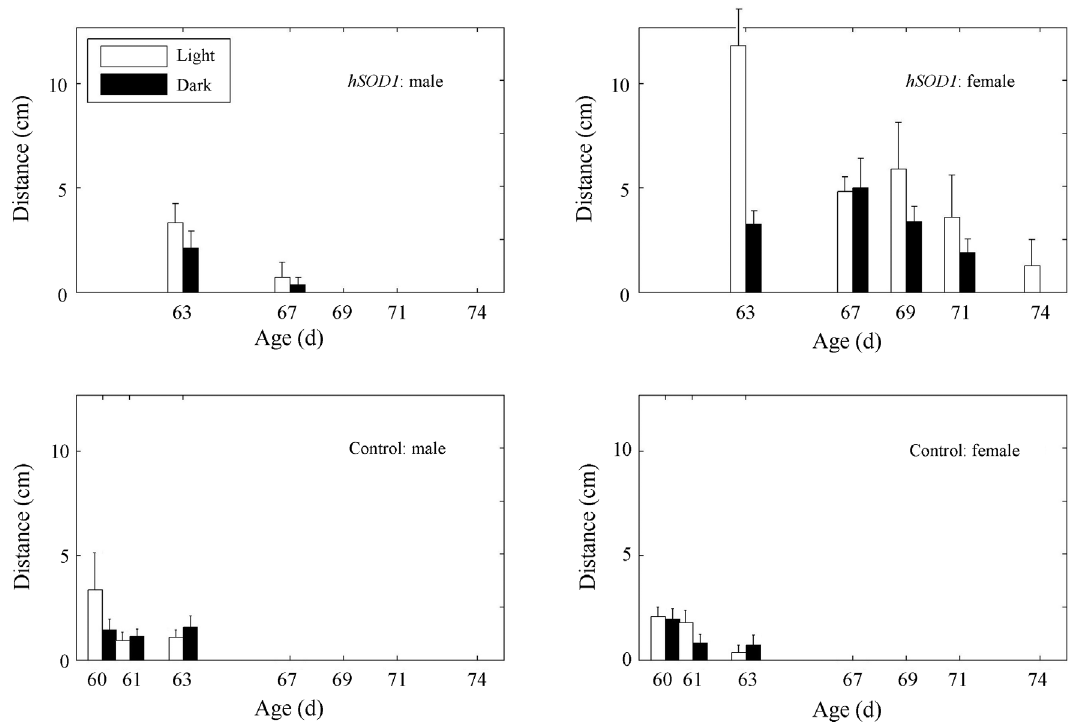
Figure 5 - Distance walked as a measure of locomotor activity for the hSOD1 (top panels) and control groups (bottom) as a function of age. Left panels show data from males and right panels for females. Black bars represent activity measured in complete darkness, and white bars under well-lit conditions. Error bars represent one standard